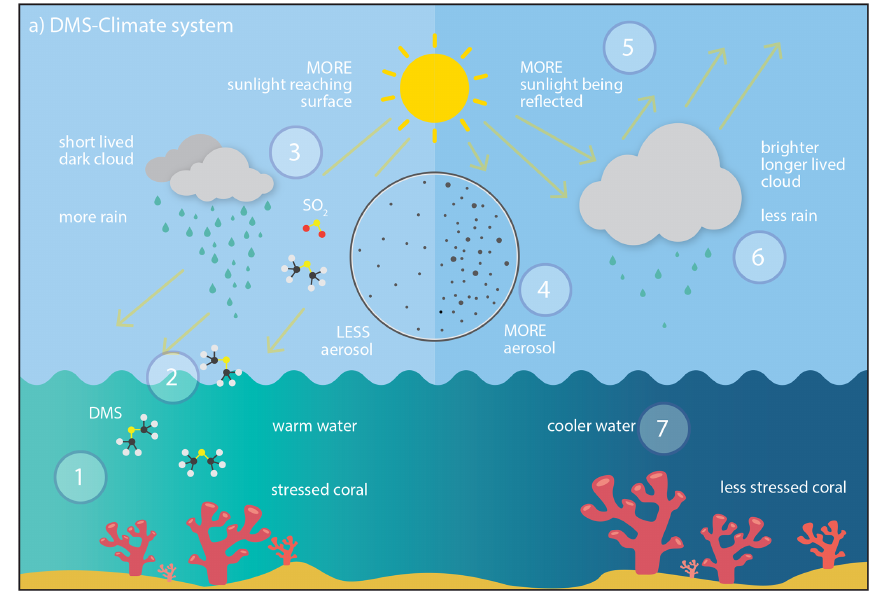
Figure 1. Schematic diagram describing the DMS–climate system. The numbers are described in detail in the text. Graphics designed by Georgina Harmer.